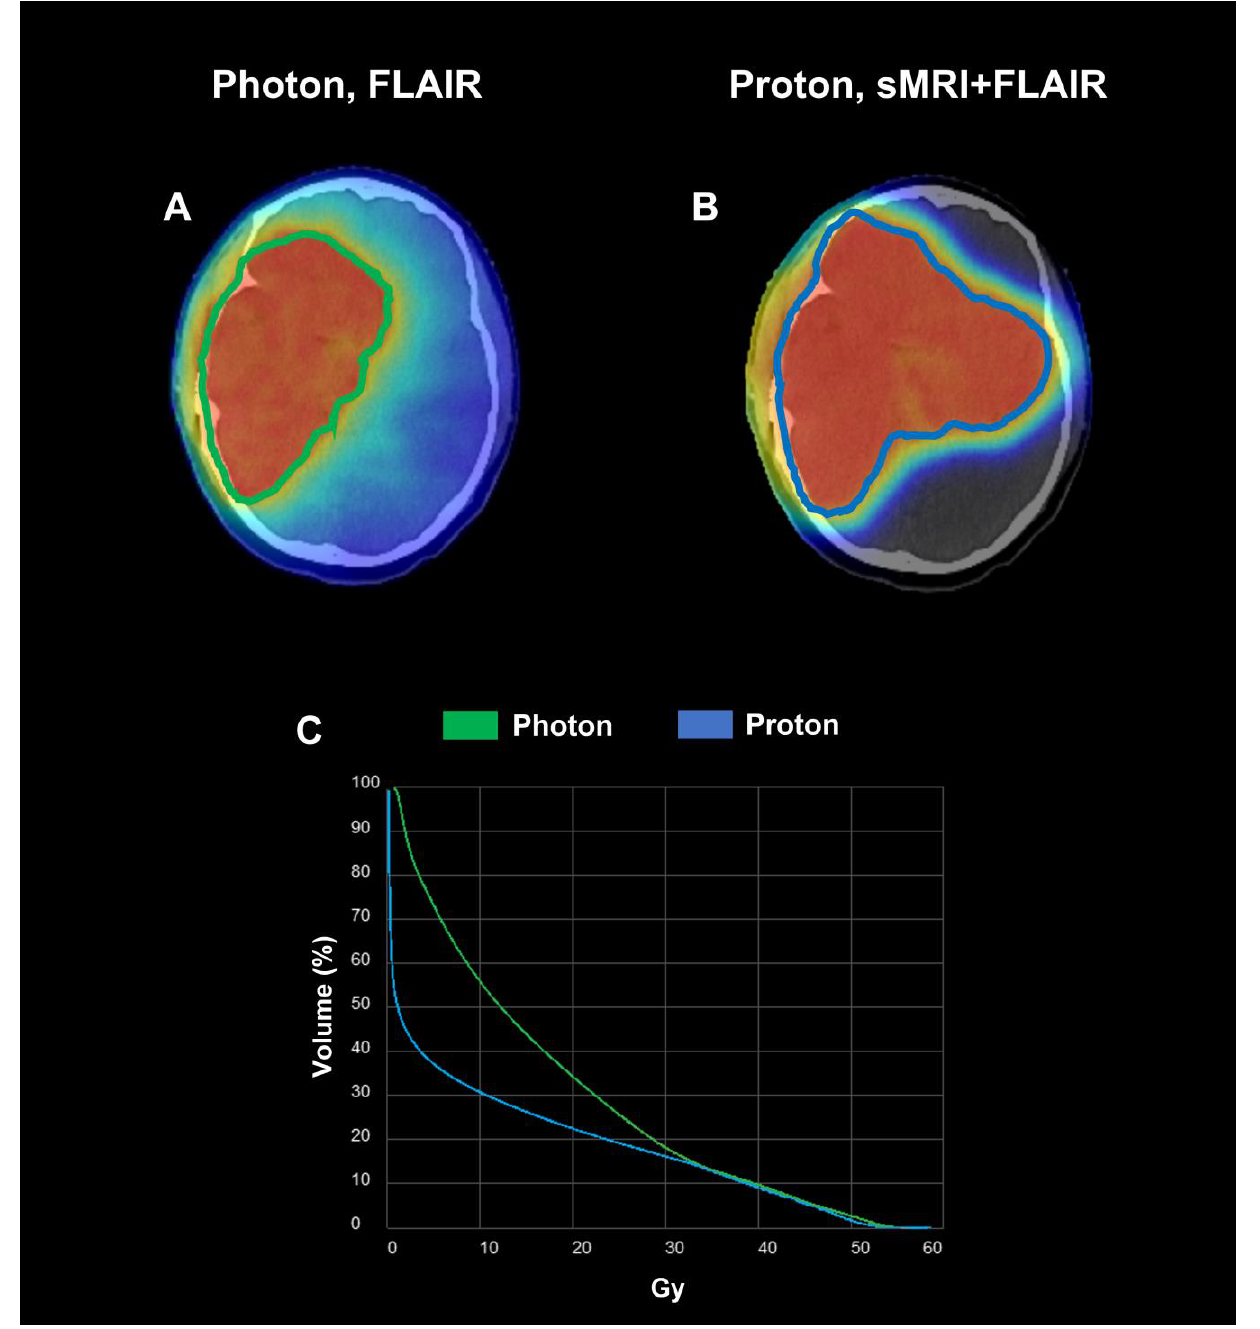
Figure 3. Comparison of photon (VMAT) and proton dose plans. The photon plan was created using cMRI with the target volume (green contour) based on the FLAIR ( A ). The proton plan was based on sMRI (Cho/NAA ≥ 2x) and FLAIR with target volume (blue contour) corresponding to the union of the sMRI + FLAIR abnormality ( B ). Both targets show volume treated to 54 Gy intermediate dose due to lack of enhancing tumor on T1w-CE. Heat map shows 54 Gy area in orange with a larger target volume for tumor and much less scattering radiation to normal tissue in the proton plan versus the photon plan as shown in the brain dose volume histogram graph ( C ).